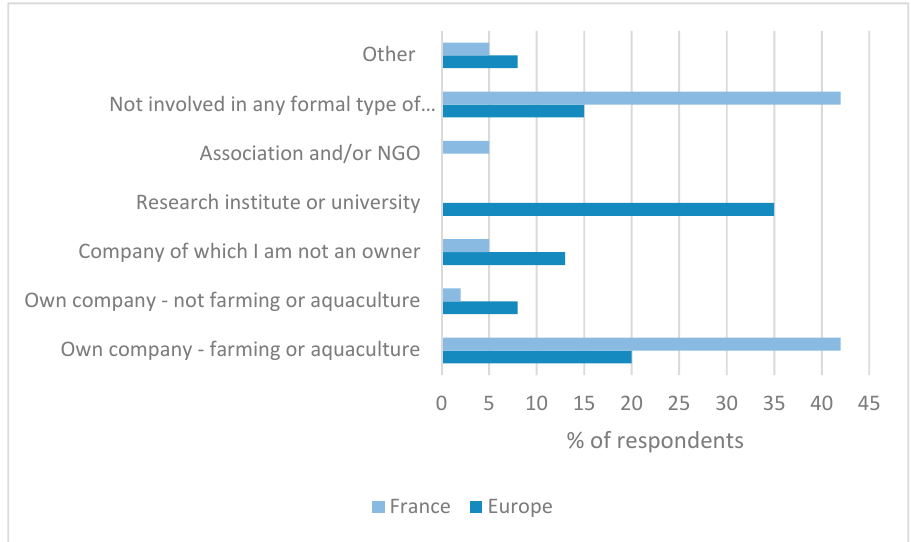
Figure 3. Answers to the question: What type of an organisation have you been in or still are involved in when planning or considering aquaponics as a potential business idea or a social/community project? One or more answers were selected.